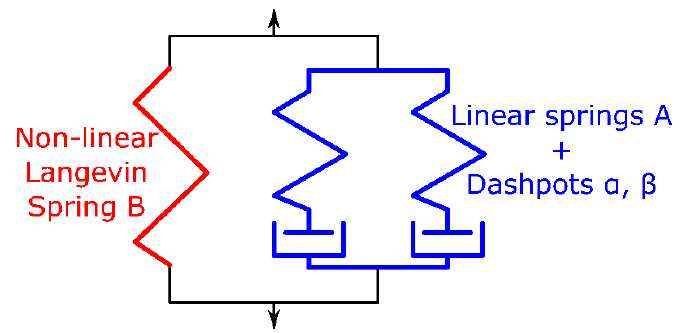
Figure 10. One-dimensional rheological constitutive model [20].